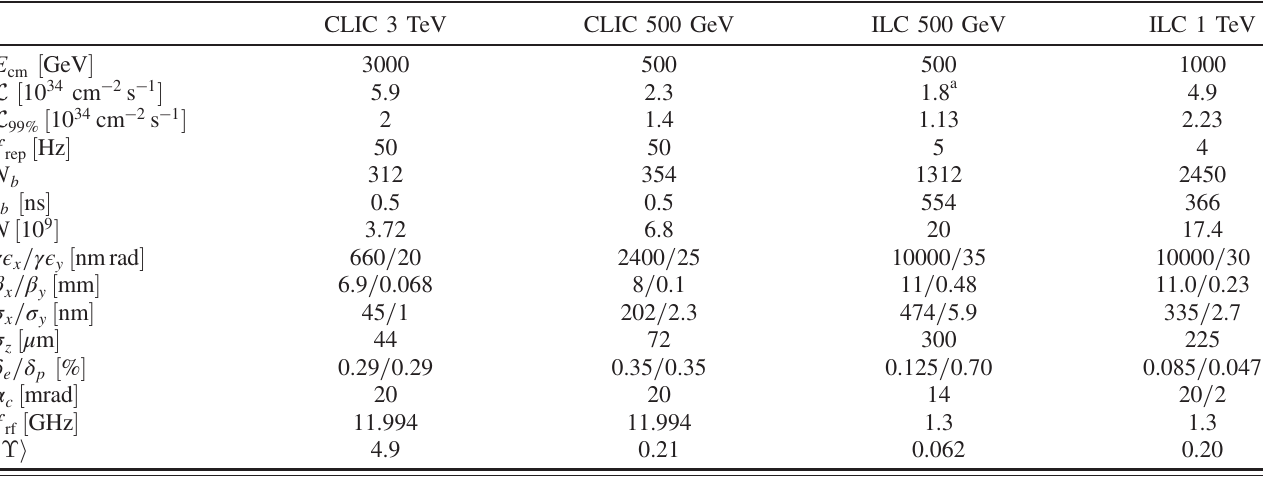
TABLE I. E : CM energy; L : total luminosity; L 99% : luminosity within 1% of the nominal CM energy; f cm N t N : number of particles per bunch; γϵ b : number of bunches per train; b : time between bunches; emittance; β x;y : horizontal, vertical beta function at the IP; σ x;y;z : horizontal, vertical, longitudinal beam size at the IP; δ e;p : relative electron/positron energy spread; α c : crossing angle; f : accelerating radio rf